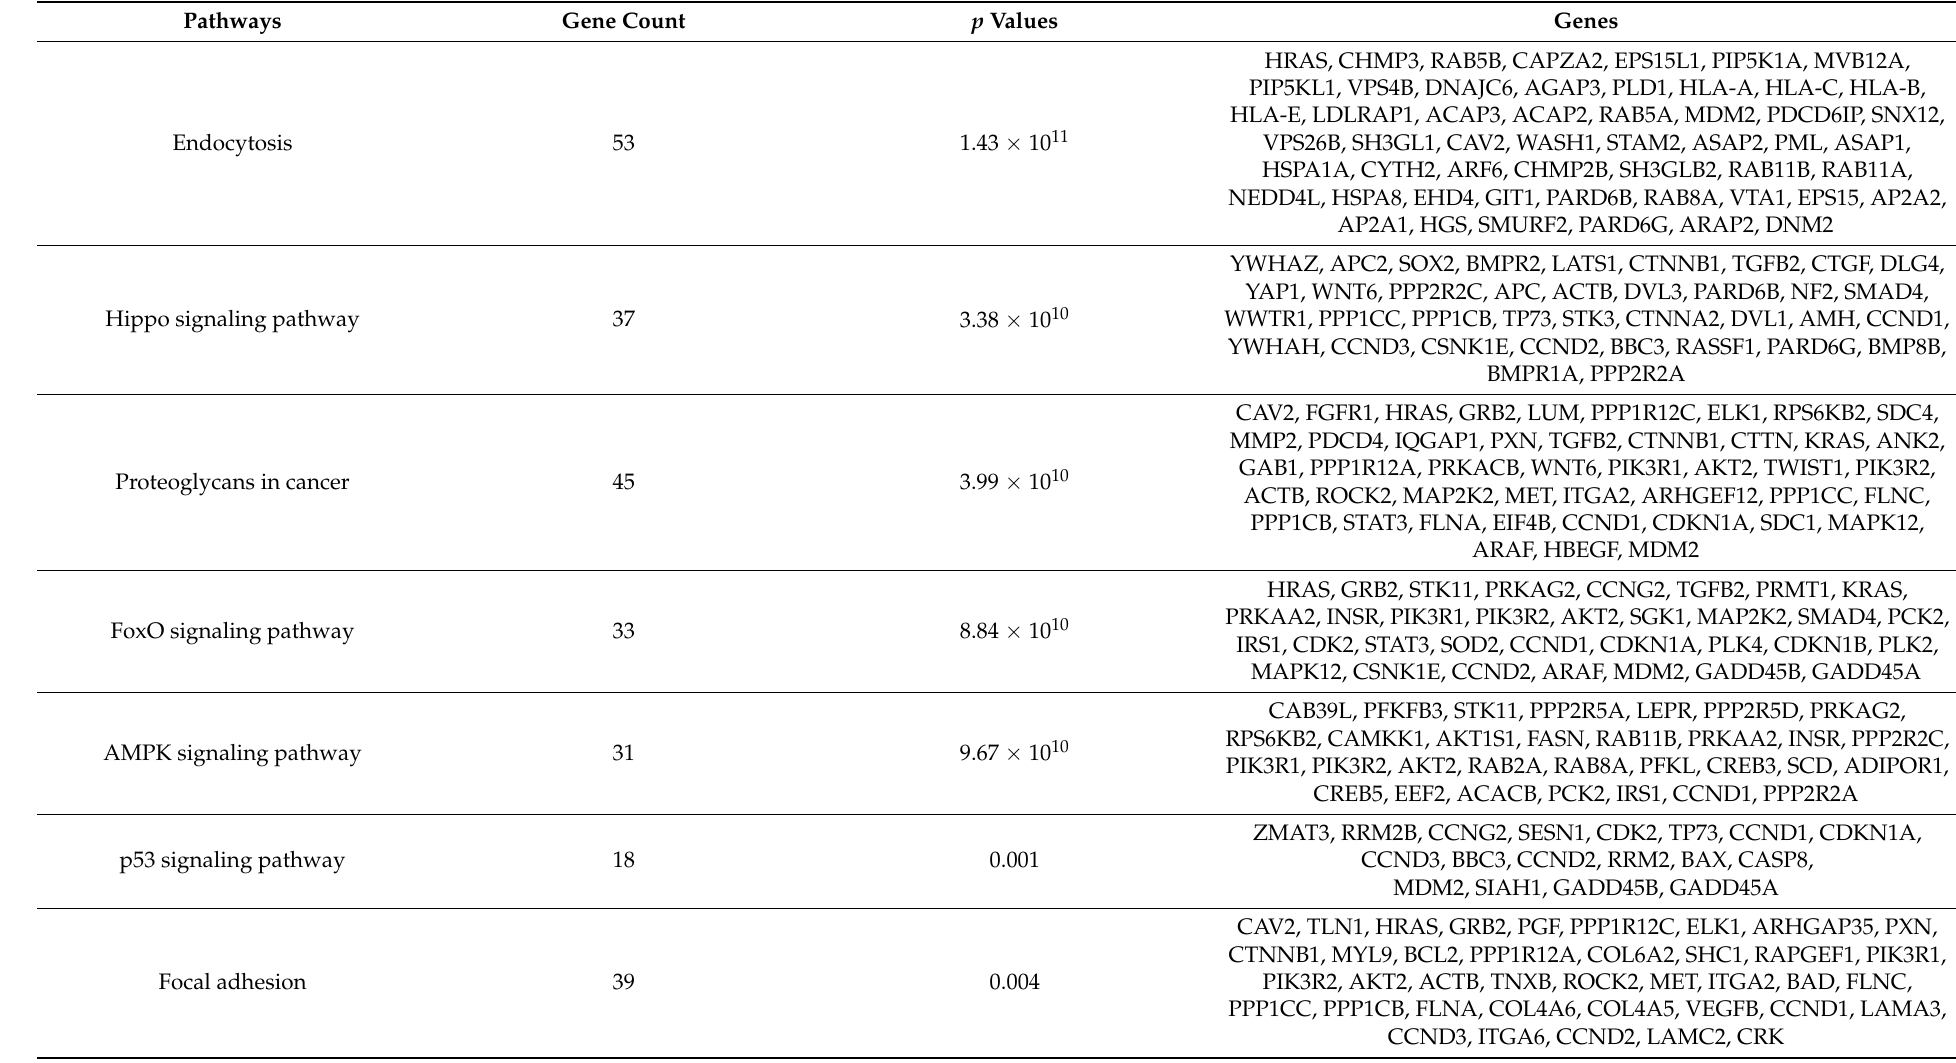
Table 3. Top 15 statistically relevant pathways activated in the U87 glioblastoma cells exposed to 10 Gy PT irradiation under acute hypoxia